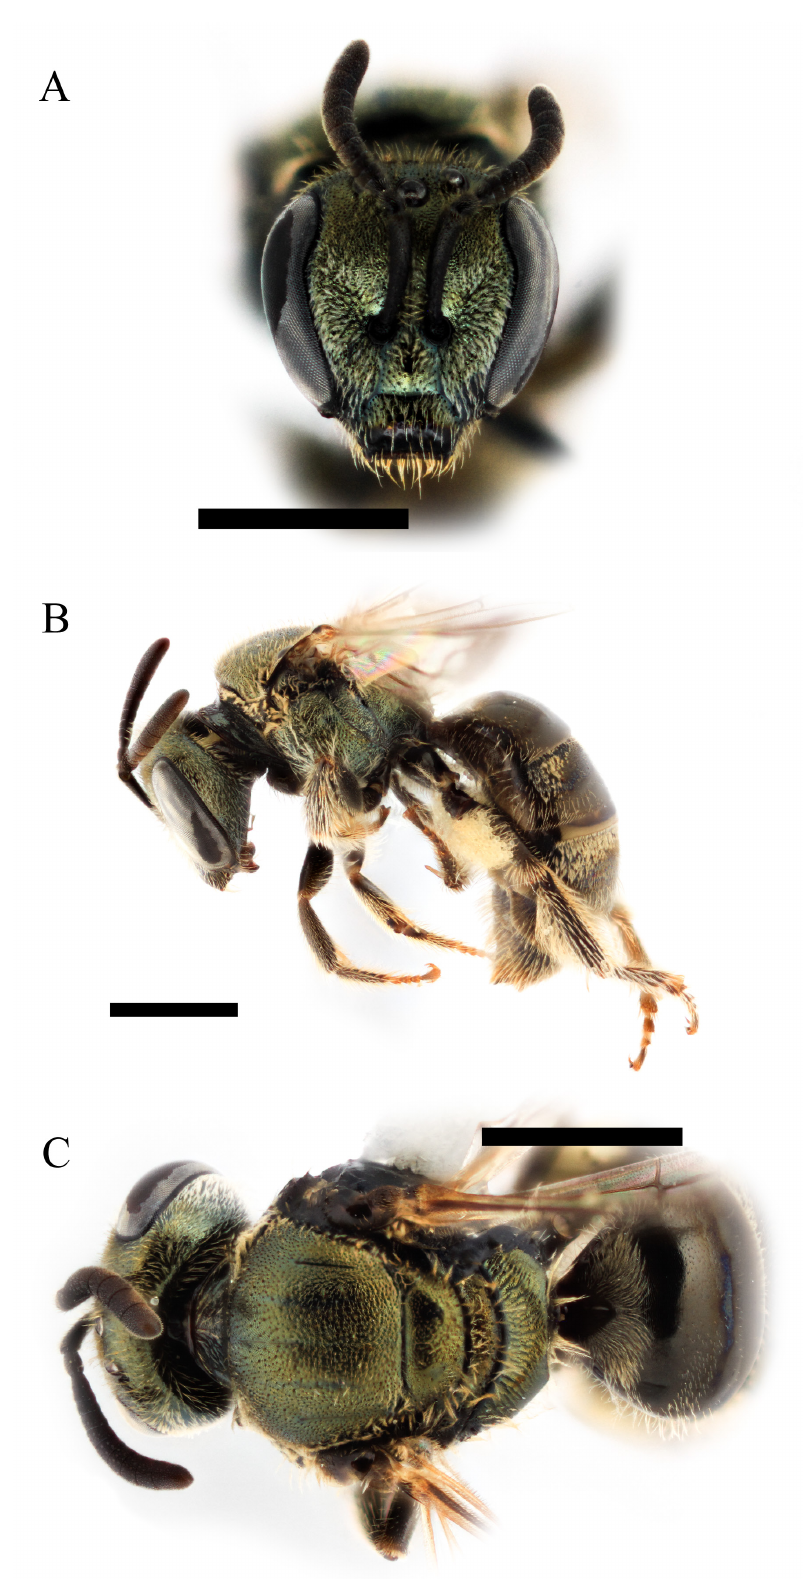
Fig. 5. Lasioglossum ( Dialictus ) kilpatrickae sp. nov. Holotype, ♀. A . Face. B . Lateral habitus. C . Dorsum of mesosoma. Scale bars = 1